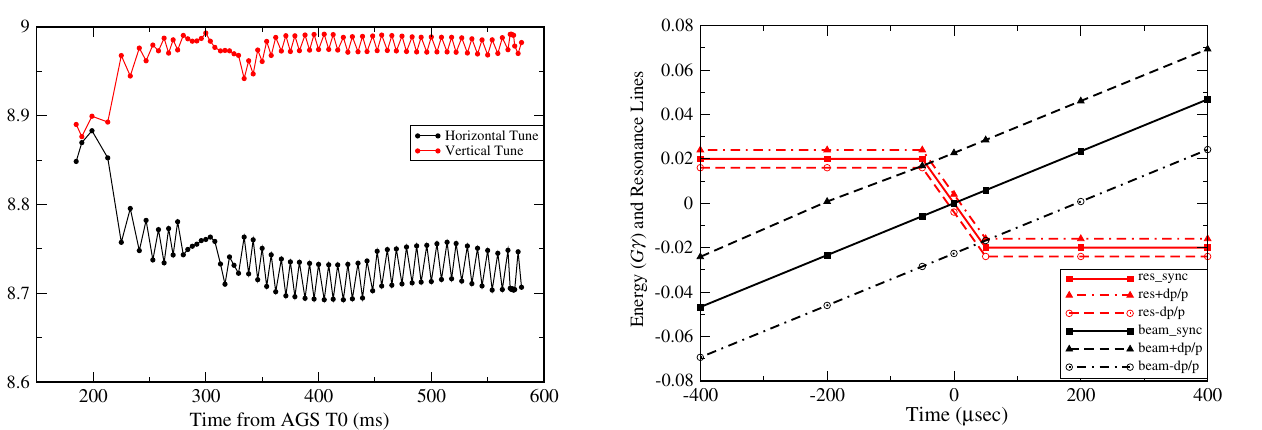
FIG. 7. The measured betatron tunes along the ramp as function of time from AGS T0. The transition is crossed at 313 ms. Note that there was no tune jump around 300 ms to avoid transition.